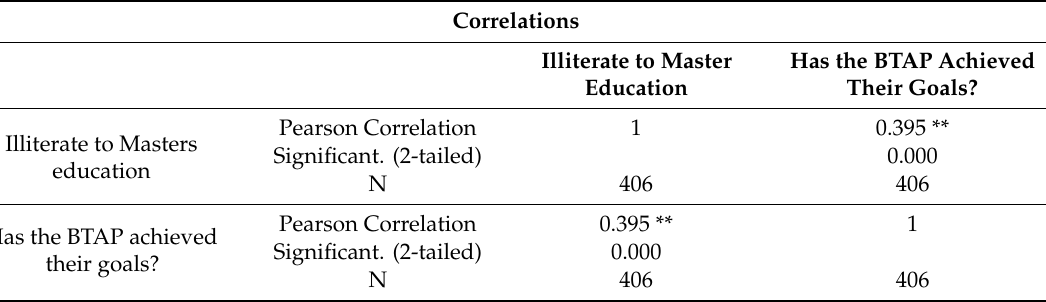
Table A13. Education correlations results.